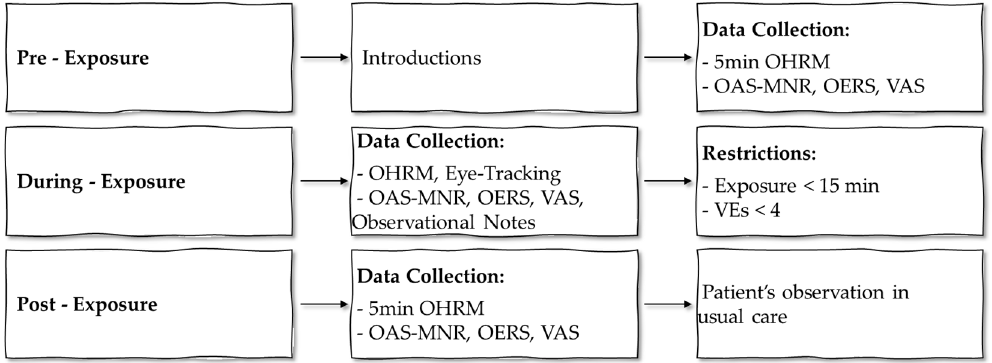
Figure 1. Study design and procedure.